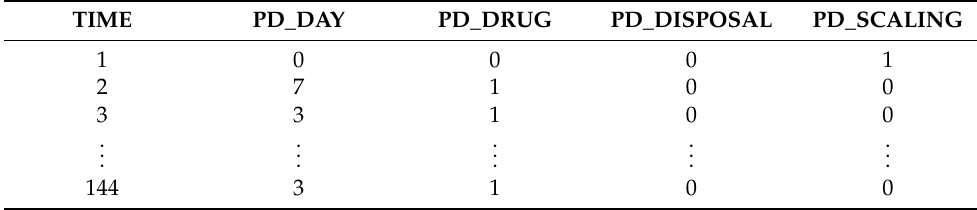
Table 1. Calculation method of PD development matrix representation.